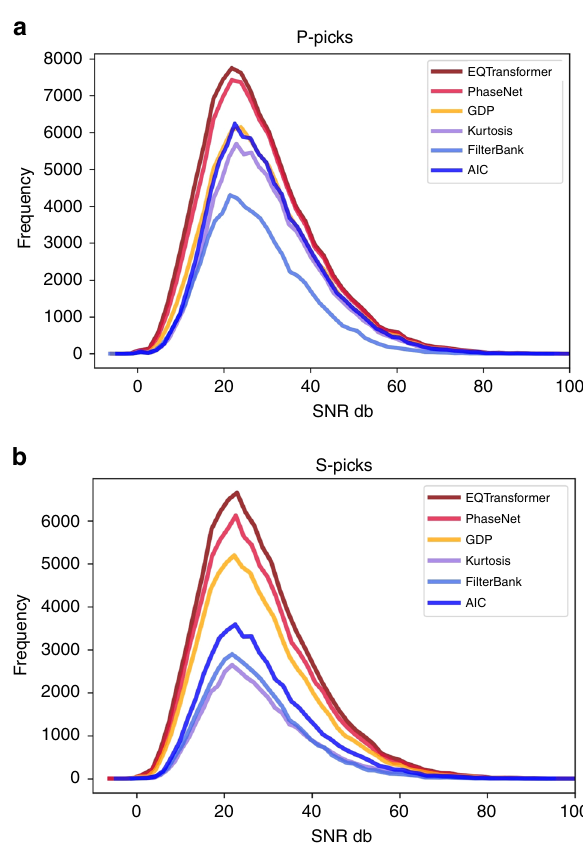
Fig. 7 Phase picking performance as a function of noise level. P ( a ) and S ( b ) phase picks as a function of signal-to-noise ratio (SNR) for three deep- learning and three traditional